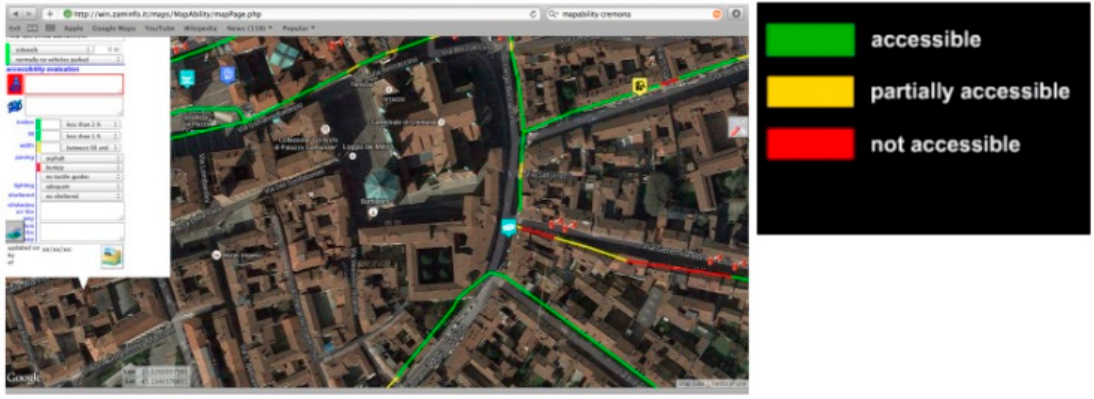
Figure 2. Cremona Interface Mapability. Source: www.mapability.org.